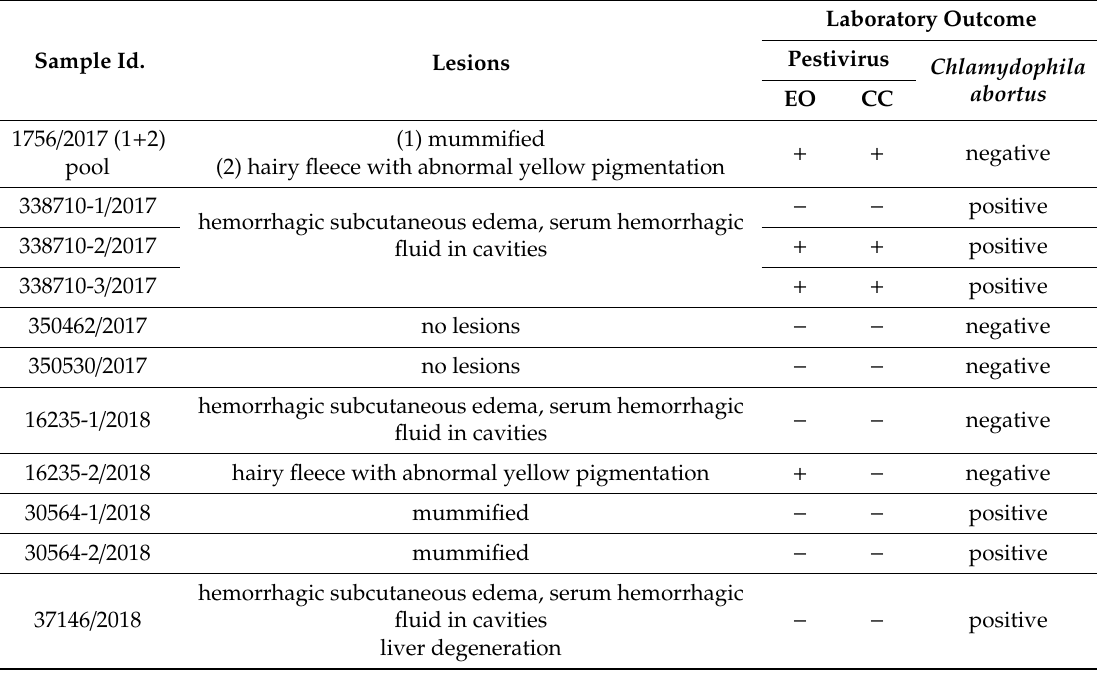
Table 1. Lamb fetuses examined in this study, lesions detected, and results for pestivirus on both original extracts (EO) and cell culture (CC), and Chlamydophila abortus .